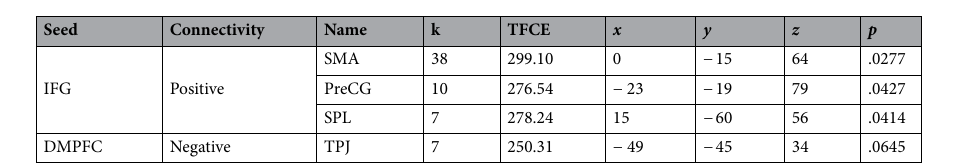
Table 3. List of functional connectivity findings that are associated with the loneliness score. k: voxel size, TFCE: Threshold-free cluster enhancement value; x,y,z: coordinates in MNI; DMPFC: Dorsomedial prefrontal cortex; IFG: Inferior frontal gyrus; PreCG: Precentral gyrus; SMA: Supplementary motor area; SPL: Superior parietal lobule; TPJ: Temporoparietal